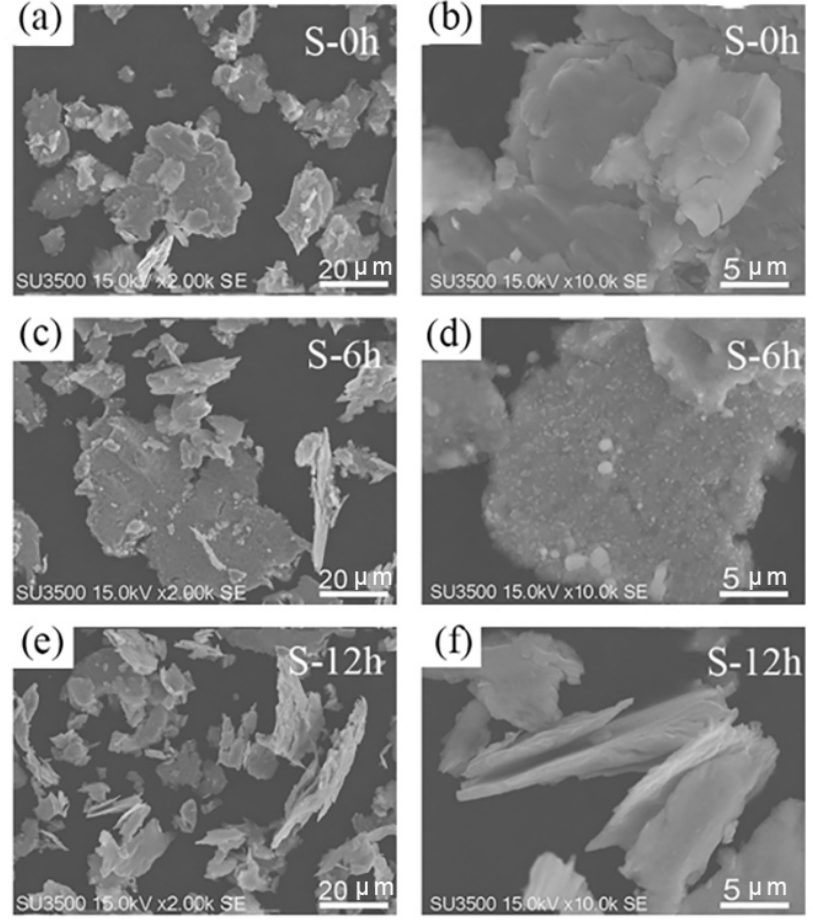
Figure 1. SEM image of NiCoMnSn flakes: ( a , b ) S − 0h, ( c , d ) S − 6h, and ( e , f ) S − 12h.